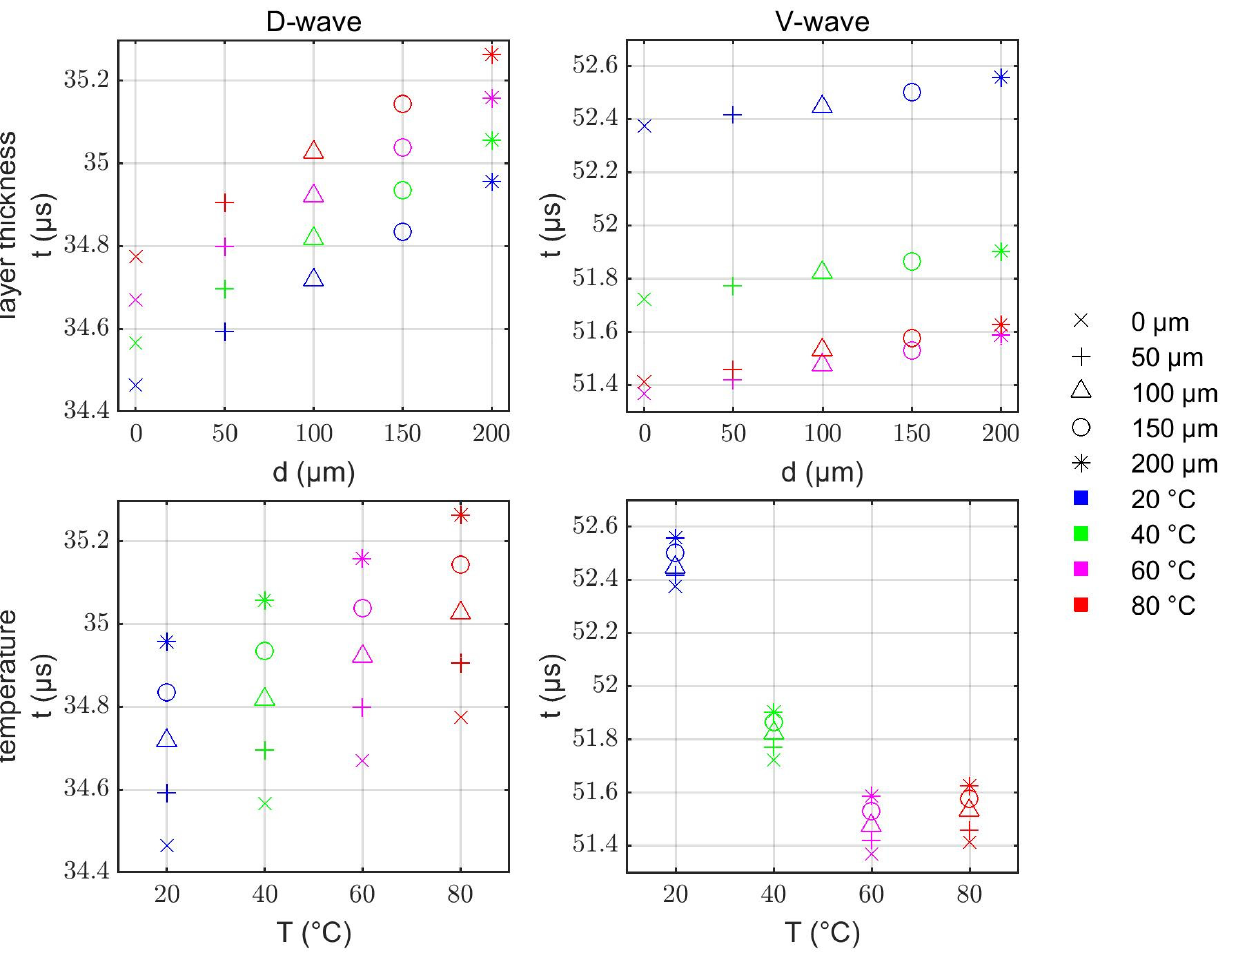
Figure 7. Evaluated propagation times t D and t V related to changes in layer thickness (d) and temperature (T). The trends show independent sensitivities to the individual parameters. These data points are used for testing the evaluation algorithm in Section 3.3.